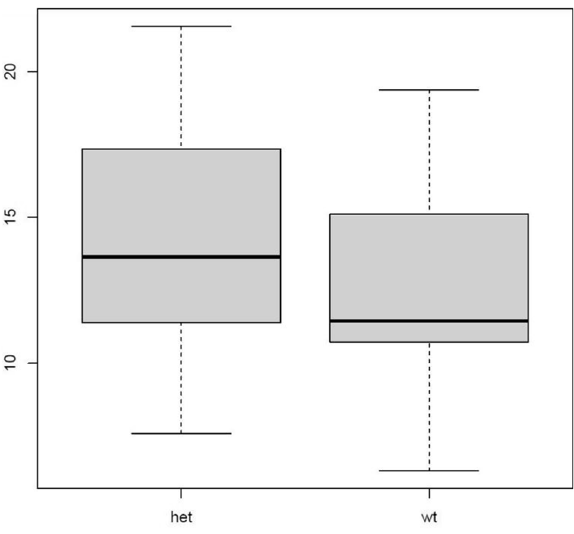
Figure 4. Mean first bowel movement time by genotype (difference of 1 h and 31 min) obtained from electronic daily diary for CRY1Δ11 variant group (n = 33) and WT controls (n = 34) p wilcoxon = 0.002 (y-axis is time in